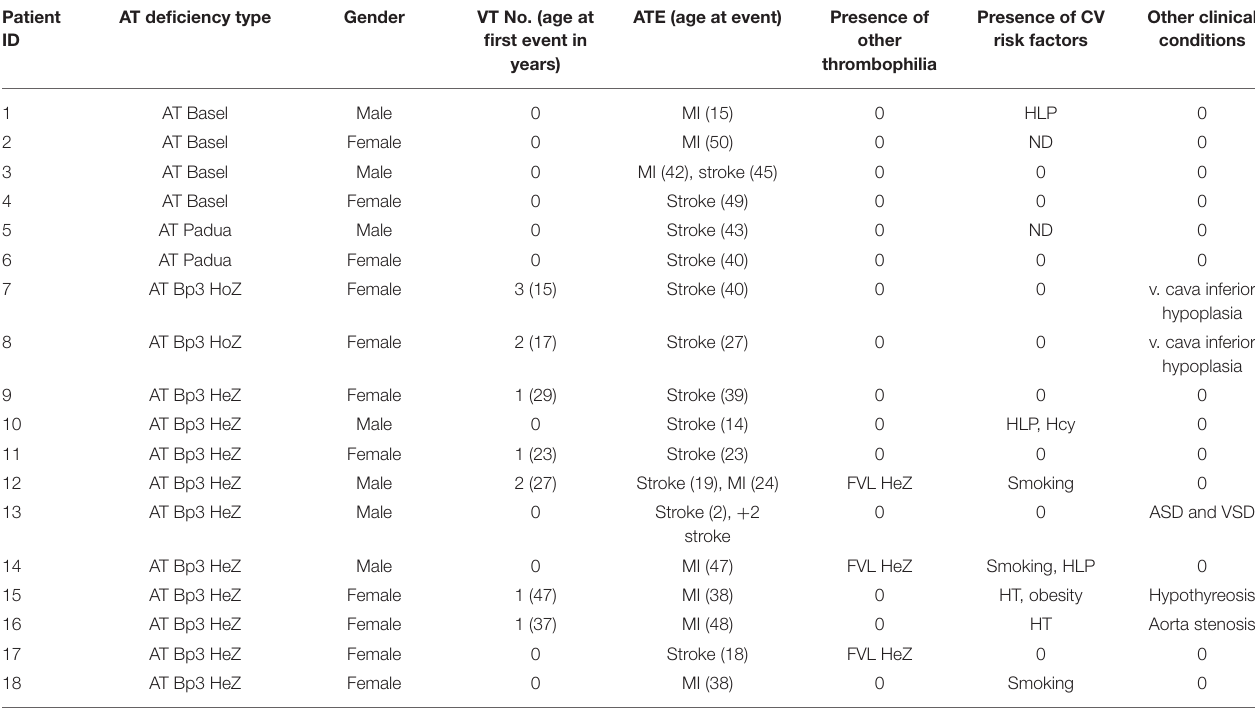
TABLE 4 | Major clinical characteristics of type IIHBS antithrombin deficient patients with arterial thrombotic disease. Patient